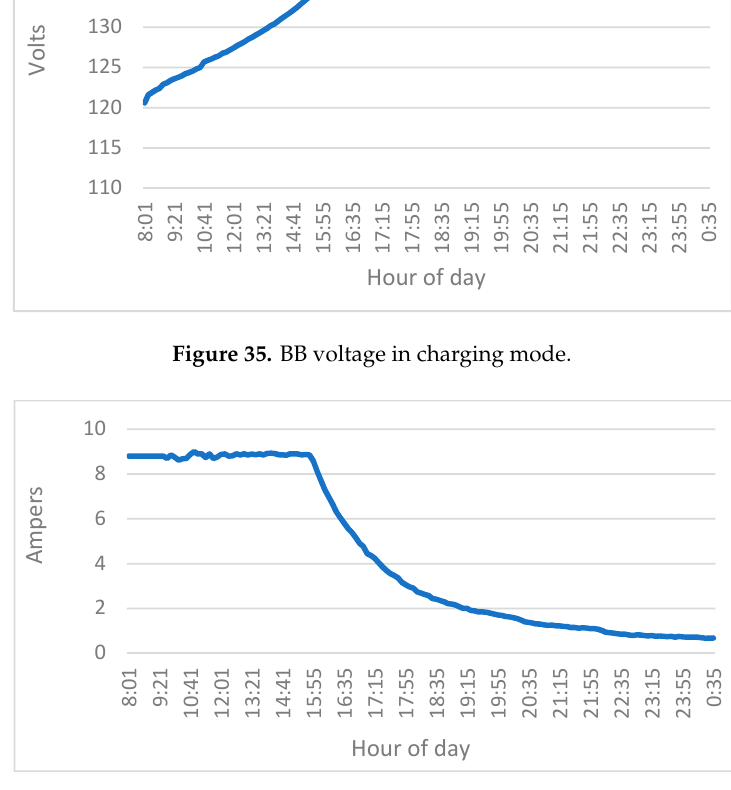
Figure 36. BB current in charging mode.